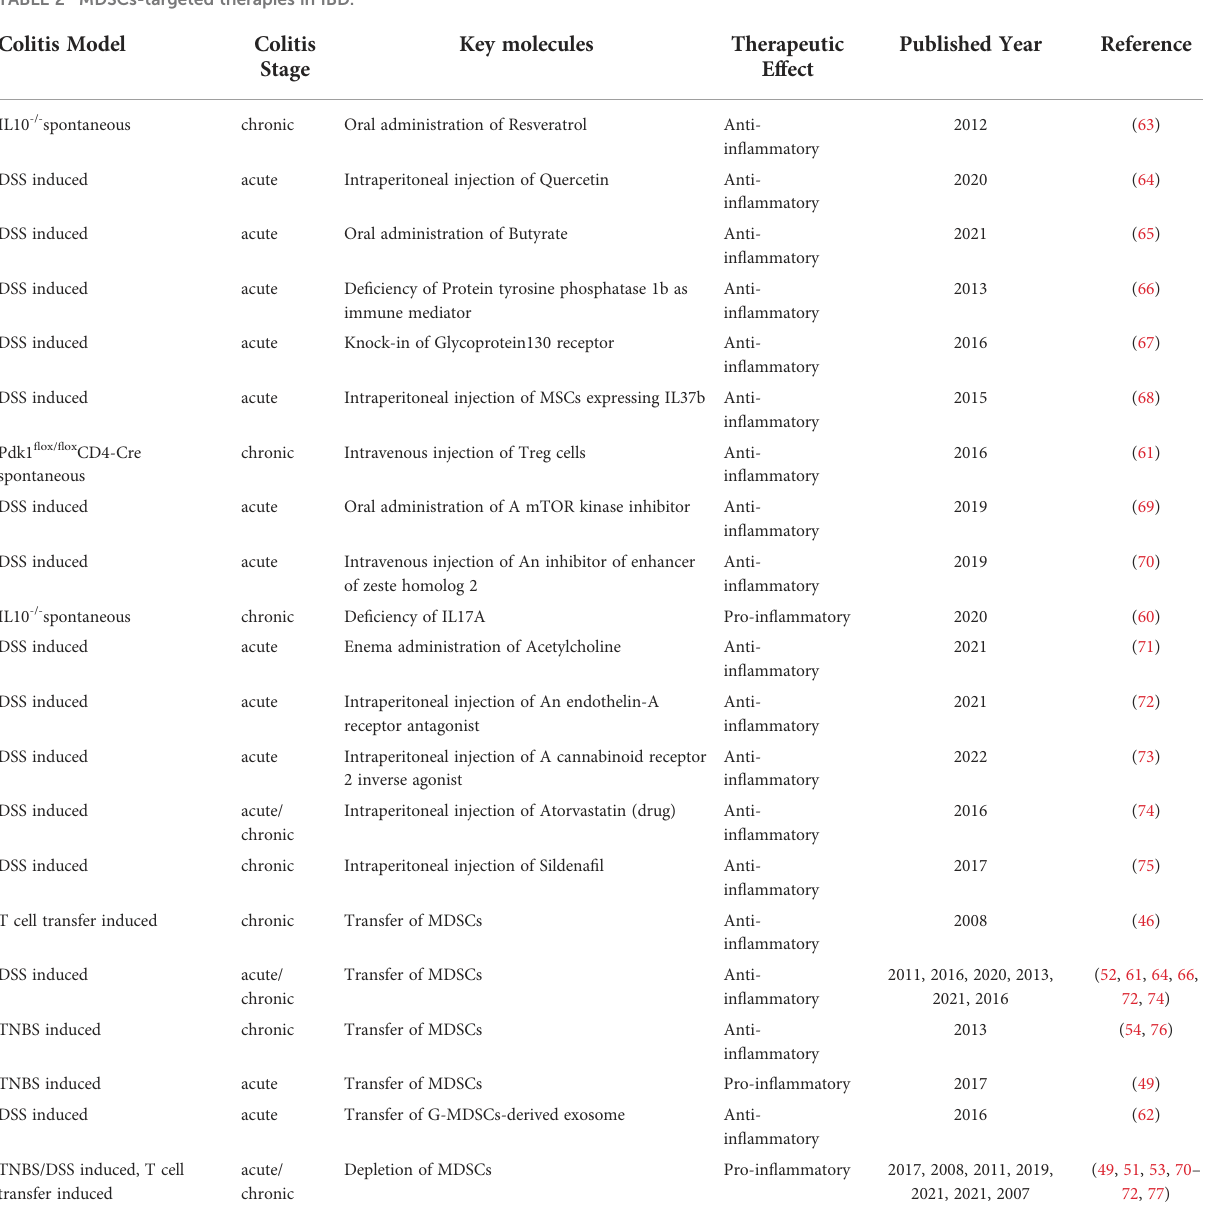
TABLE 2 MDSCs-targeted therapies in IBD. Colitis Model Colitis